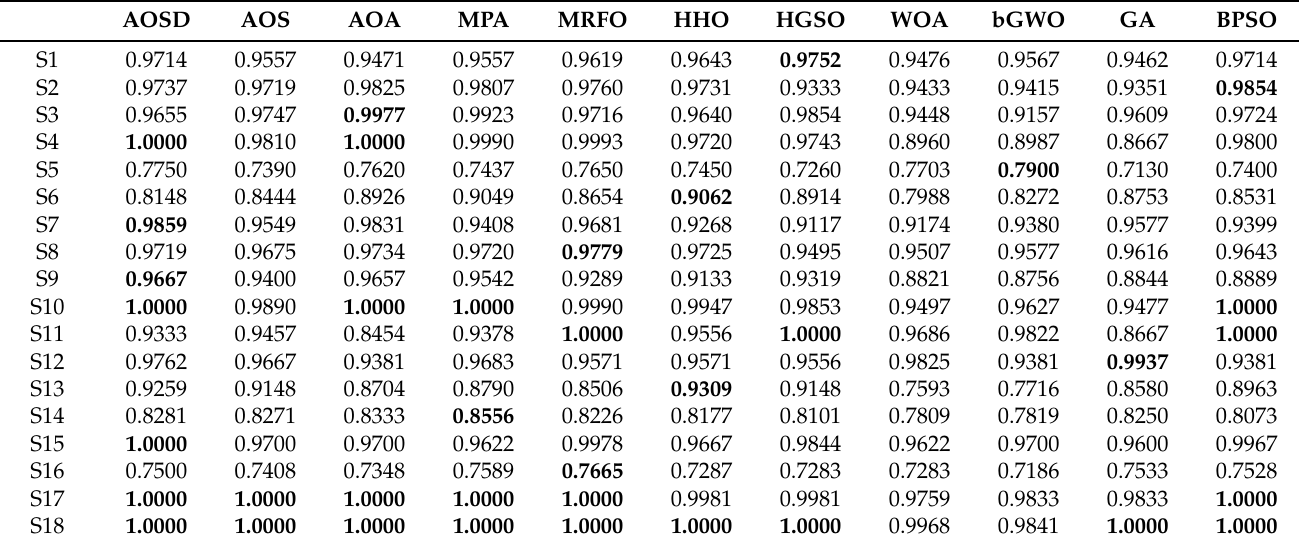
Table 8. Accuracy results for FS approaches.